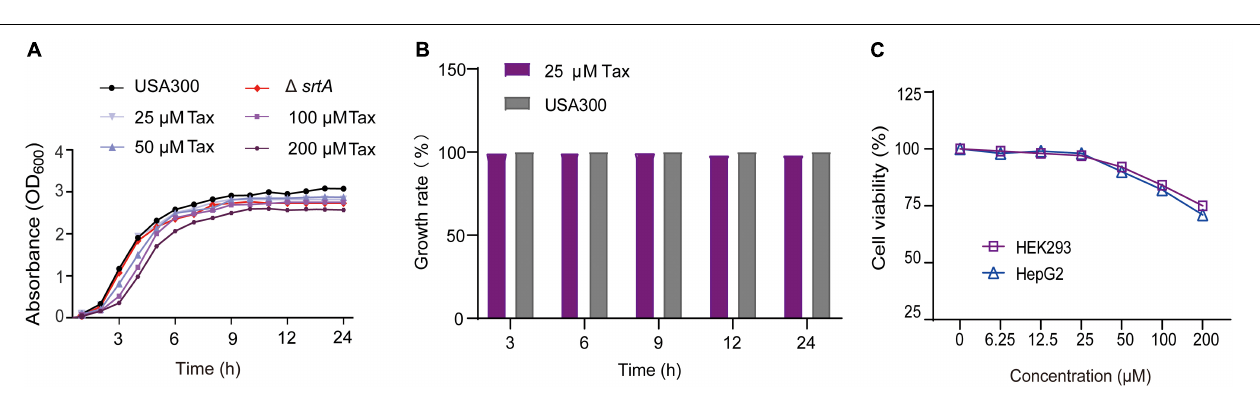
FIGURE 1 | Inhibition of SrtA transpeptidation. (A) Chemical structure of Tax. (B) Tax inhibits SrtA cleavage of a fluorogenic peptide substrate (Abz-LPATG-Dnp-NH 2 ) in a dose-dependent manner in vitro . Each reaction condition was assayed in triplicate from which the IC 50 was determined. (C) Recombinant SrtA was treated with 10 × IC 50 of Tax and then diluted, after which transpeptidation activity was measured using a FRET assay. Untreated SrtA (Control) represented 100% activity.